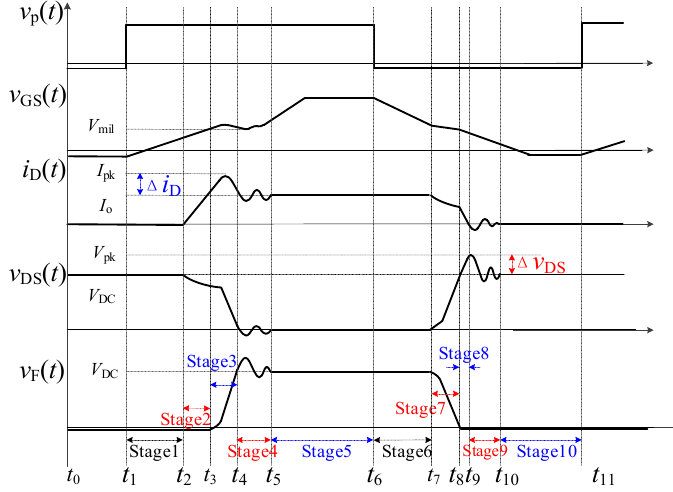
Figure 2. Switching waveforms of a SiC MOSFET and a freewheeling diode.